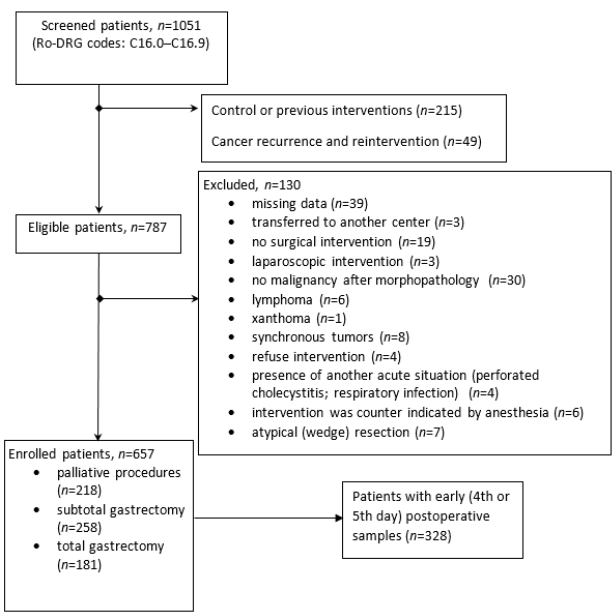
Figure 1. Flow-chart with subjects enrolled in the study.